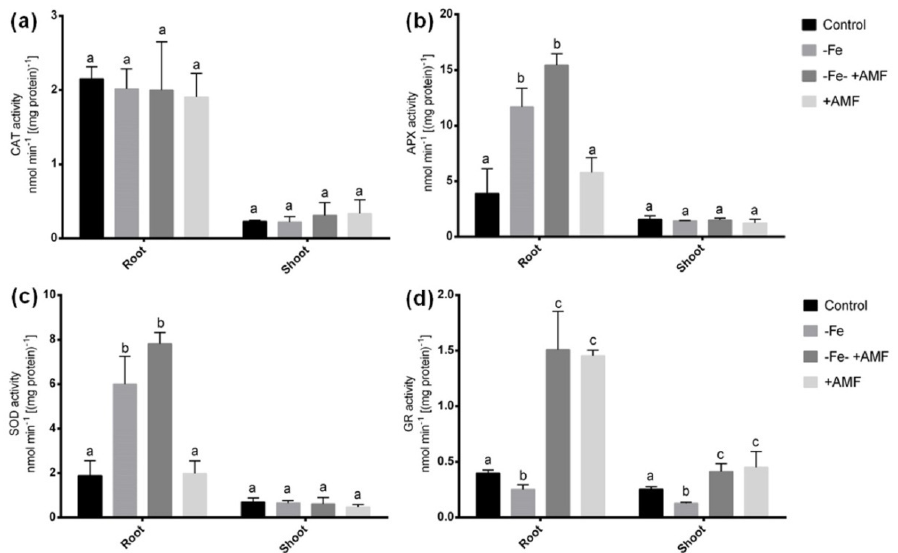
Figure 6. Effects of Fe deficiency and AMF on antioxidant enzymes activities in alfalfa root and shoot. (a) Changes of catalase (CAT), (b) ascorbate peroxidase (APX), (c) superoxide dismutase (SOD), and (d) glutathione reductase (GR) under Fe deficiency with or without AMF. Data represent means ± SD ( n = 3). Different letters above the error bar indicate significant difference at p < 0.05 level.